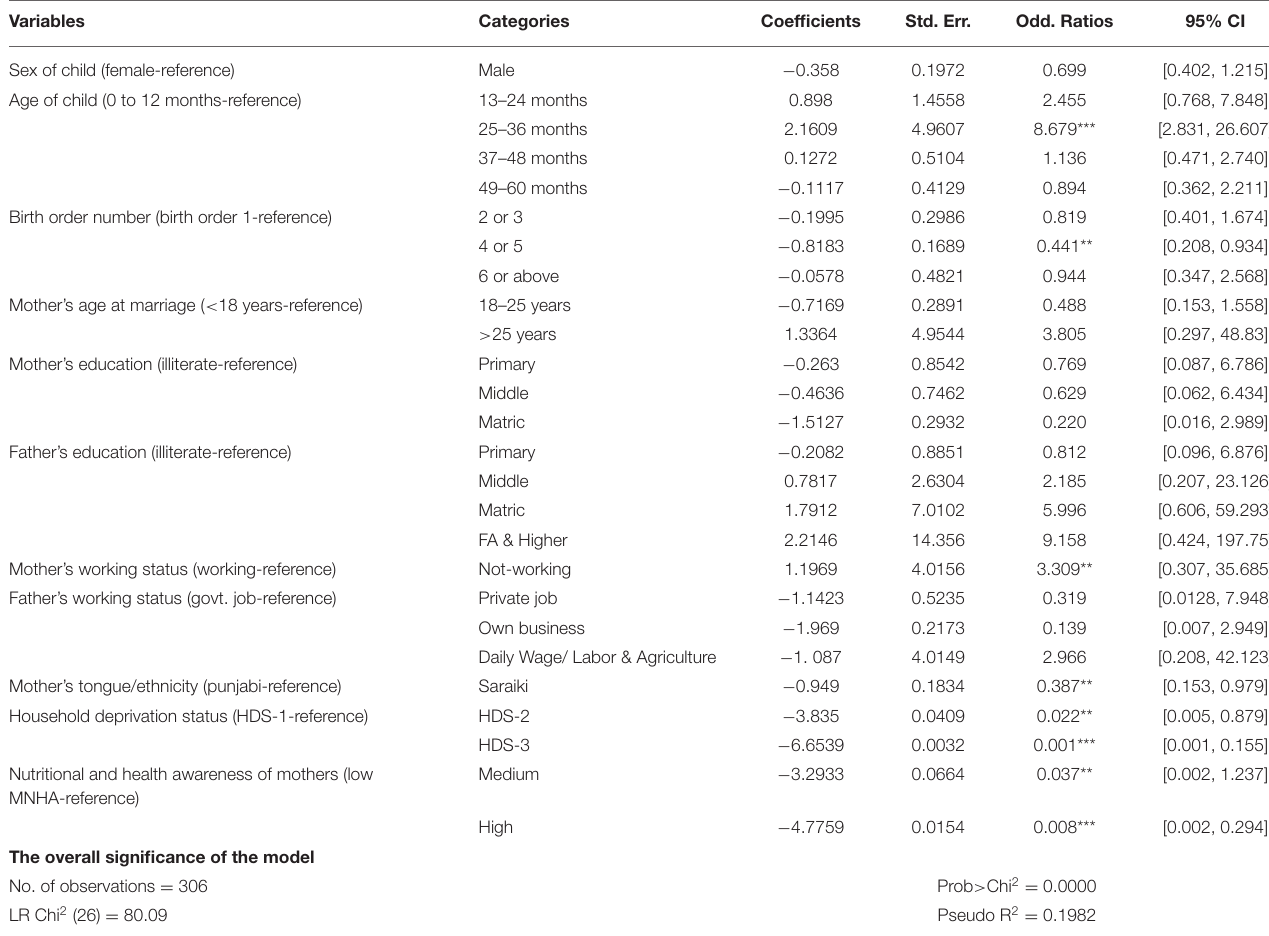
TABLE 4 | Binary logistic regression analysis results for CIAF (child malnutrition) and its correlates.